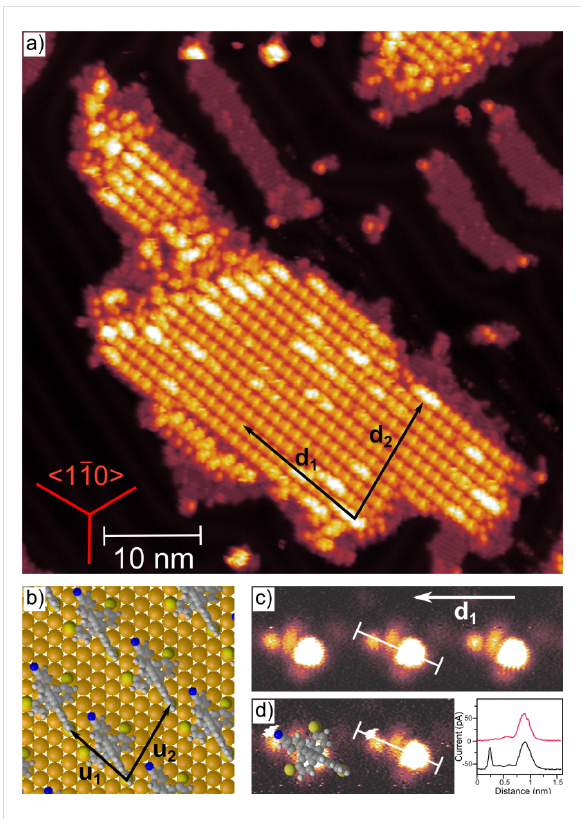
Figure 26: (a) Highly ordered island of molecular tripods 48 (yellow) and remaining CH 2 Cl 2 (dark purple) on the Au(111) surface. (b) Unit cell of the molecular islands as extracted from the directions and dis- tances in (a) with the molecular configuration as extracted from (c). (c) Constant-height mode image with submolecular resolution. (d) STM image of the same molecules as in (c) scanned at lower distance with a model of the molecule superimposed (model size is to scale). The inset cross sections show the distance between nitrile group and the spirobifluorene core. Reprinted with permission from [129], copyright 2014 American Chemical